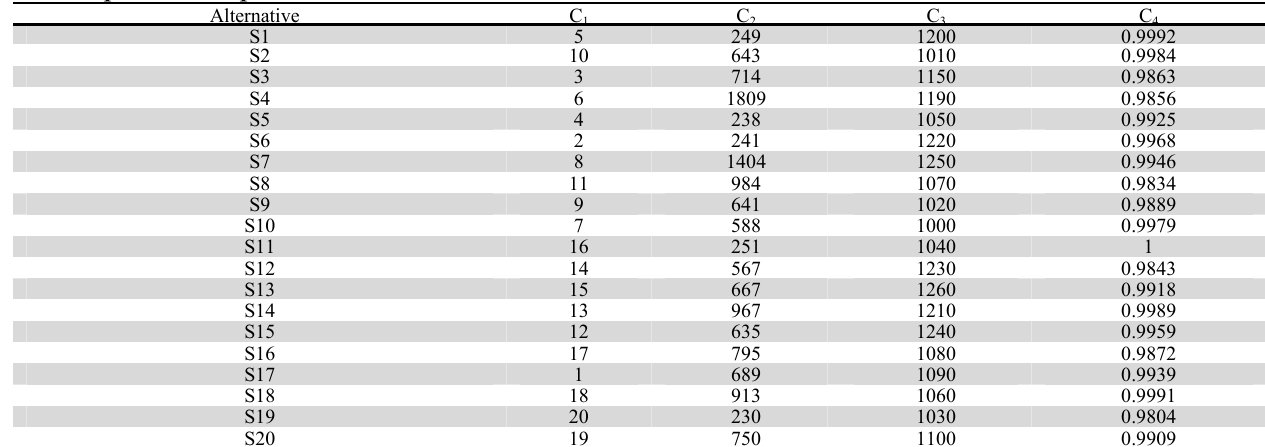
The input data of problem